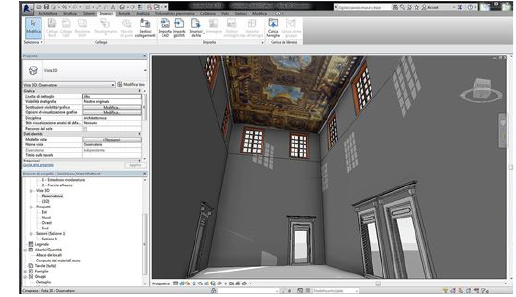
Figure 10. HBIM - Database